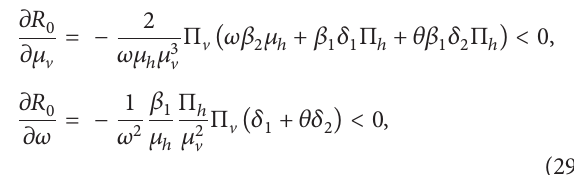
Figure 5: The effect of 𝜔 on infected vectors for Π ℎ = 0.22 , Π V = = 0.002 , 𝜔 = 0.003, 0.03, 0.07, 0.15 , 𝜇 0.32 , 𝜇 ℎ = 0.00034 , 𝛿 = 0.0016 , 𝛿 = 0.00016 , 𝜃 = 0.00301 , 𝛼 𝛽 2 1 2 and 𝛼 2 = 0.001